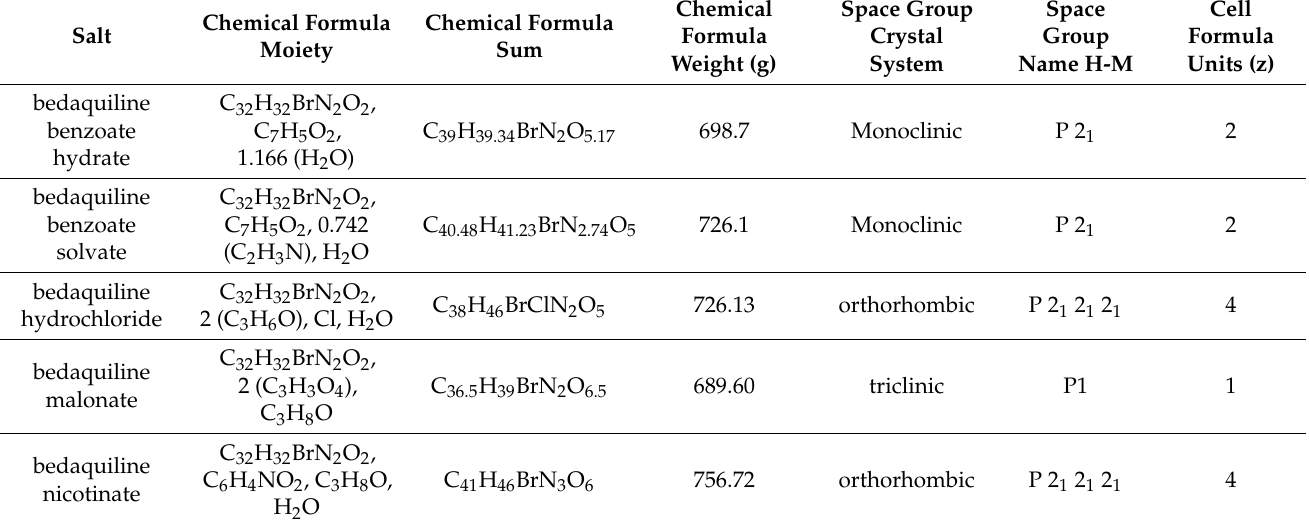
Table A4. Summary of structural elucidations for new salts of